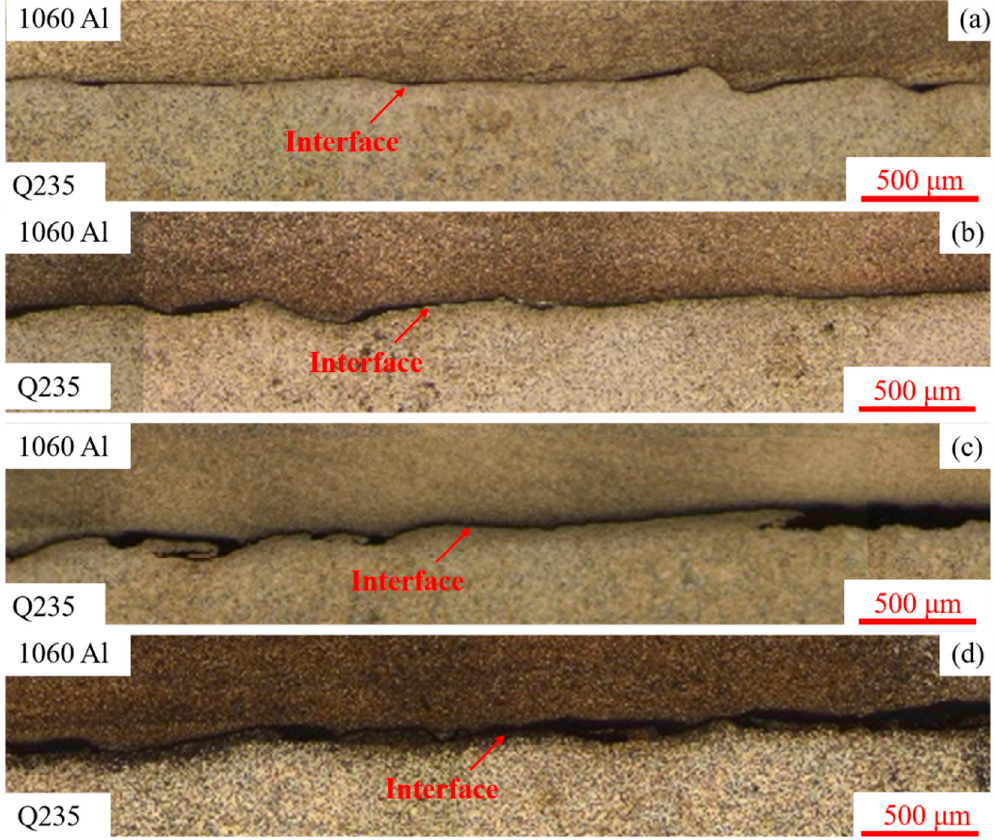
Figure 7. Interfaces of composite plate after FSP with different passes: ( a ) single pass; ( b ) two passes; ( c ) three passes; ( d ) four passes.